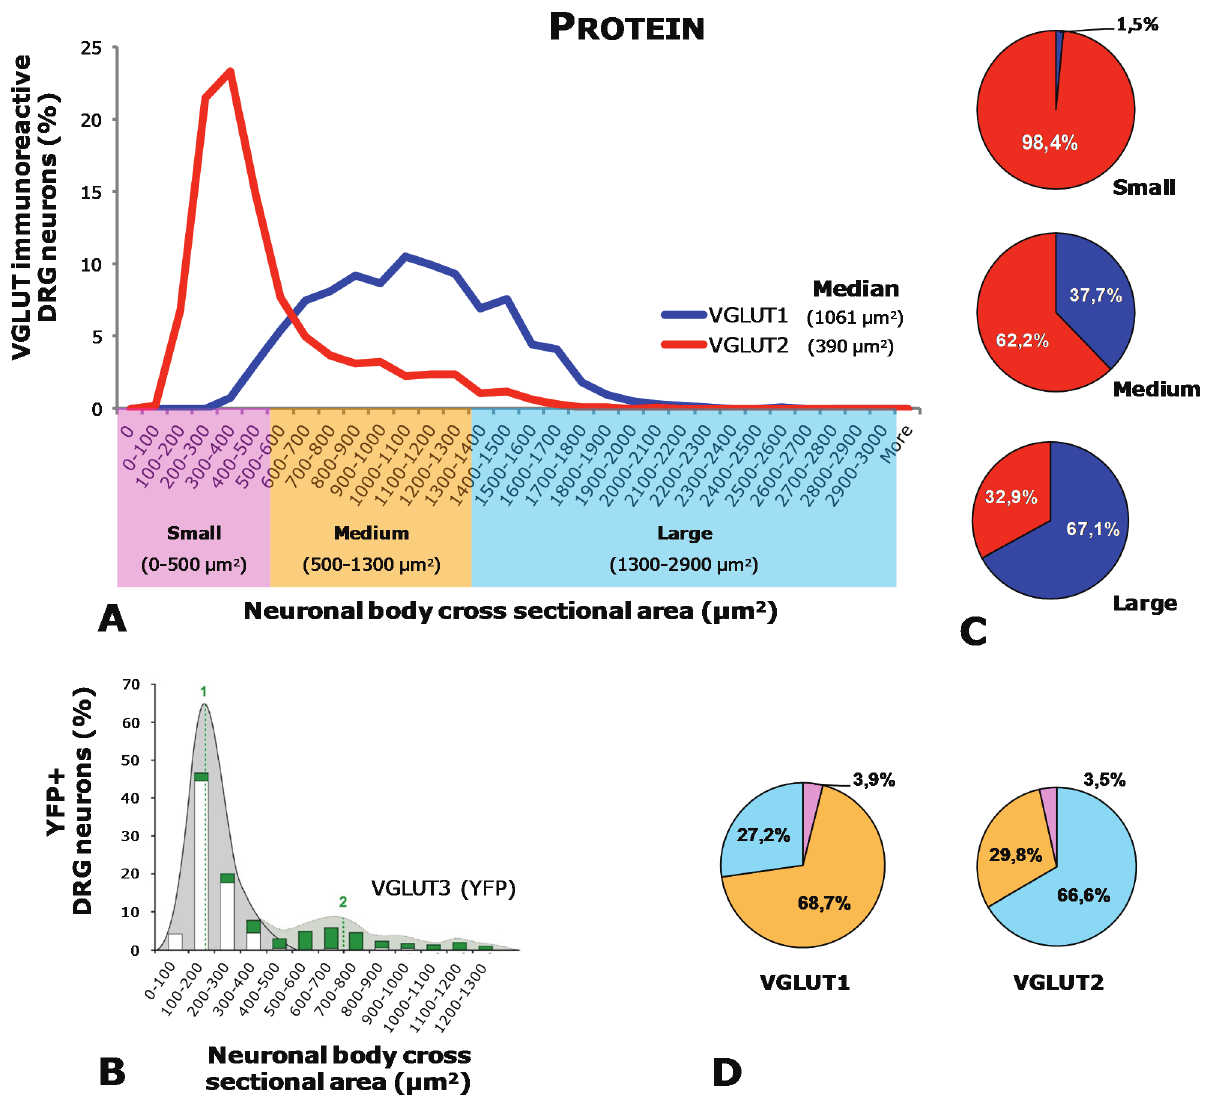
Figure 3. Neuronal size distribution of DRG neurons positive for VGLUT1-VGLUT3 protein (based on data from [9]). Figure in B was taken from [31] and partially modified